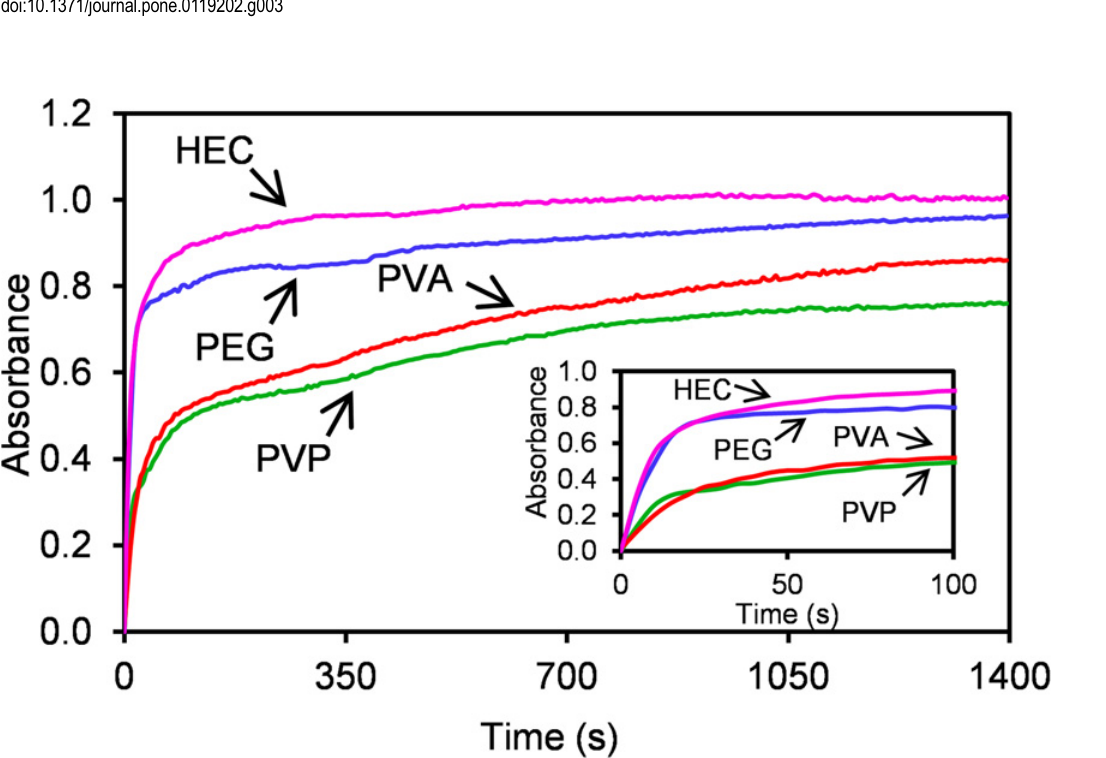
Fig 4. Kinetic curves for AgBr nanoparticles reduction by NaBH 4 in the presence of studied polymers ( λ max represent position of absorption maxima) and zoom of the first 60 seconds (inset).